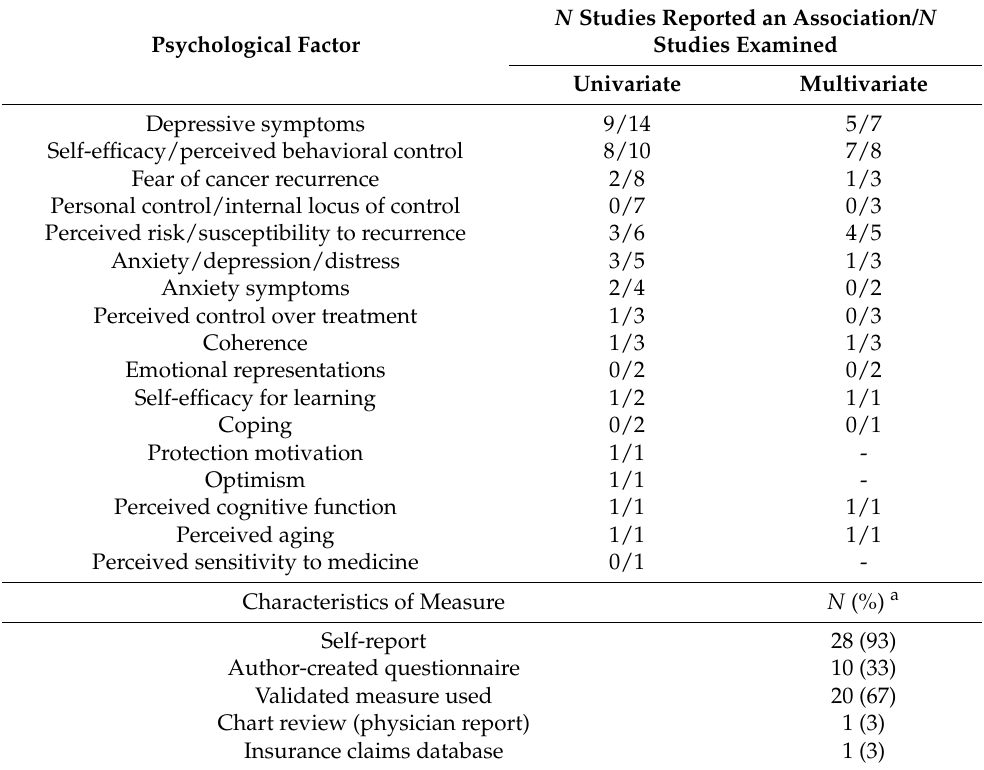
Table 5. Characteristics of studies that measured psychological factors ( N =